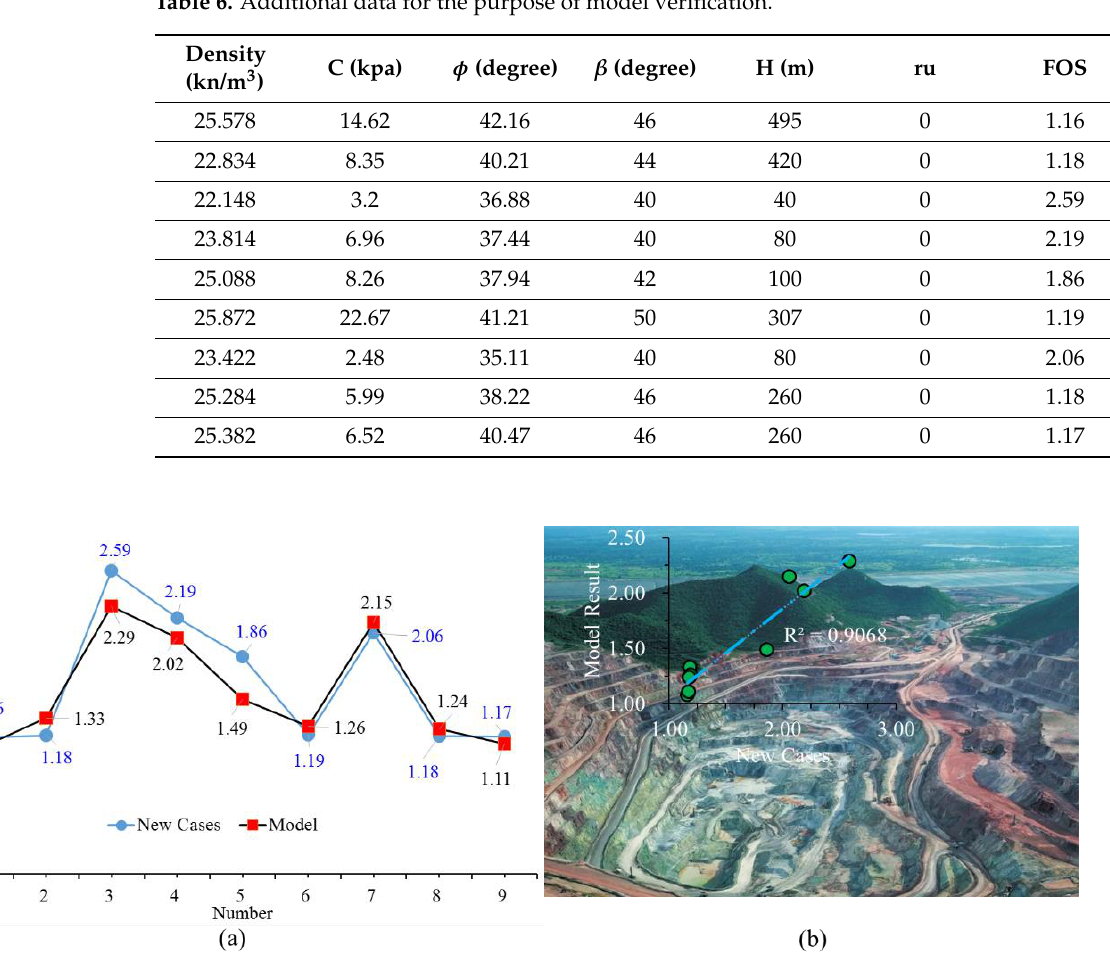
Figure 13. FOS results of new cases obtained by the developed radius basis function (RBF)-SVR model: ( a ) predicted v.s. measured, and ( b ) a view of L & K mine of Monyova copper